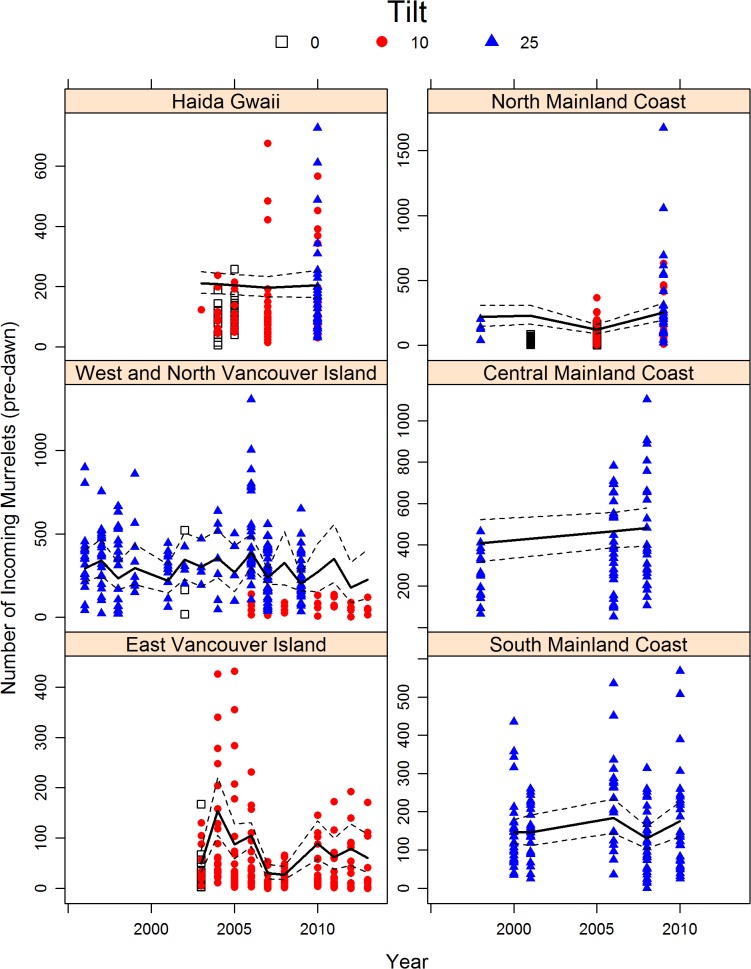
Temporal trends in the number of Marbled Murrelets counted at radar stations distributed through six Conservation Regions in British Columbia, 1996–2013.Thick lines indicate predicted means from trend model, with 95% credibility intervals that depict the within-Region yearly-variation. Colour and shape of symbol indicate radar tilt: 0 (which include 0 and 5.2 degree tilts, open squares), 10 (which include 10, 11.3 and 12.8 degrees, red circles) and 25 degrees (blue triangles).